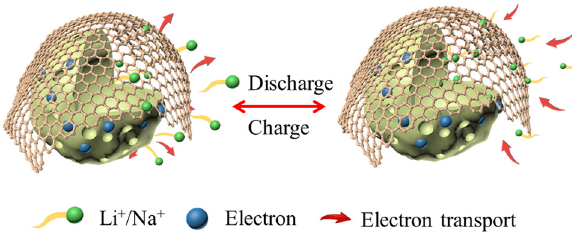
Figure 7: Schematic illustration of the enhanced ion/electron transport of the Zn 0.76 Co 0.24 S@N/S -